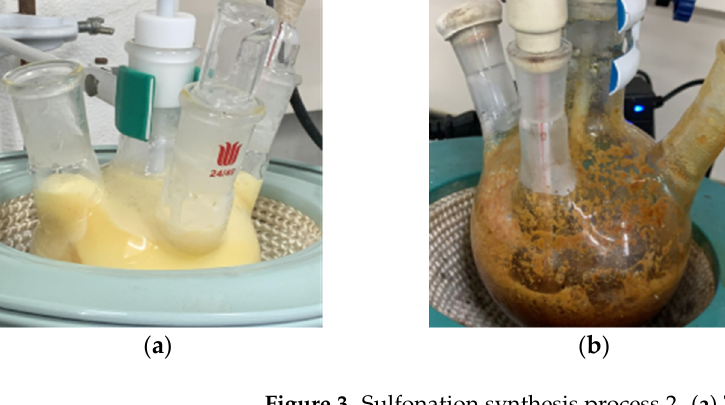
Figure 3. Sulfonation synthesis process 2. ( a ) Temperature rise to 110 °C for reaction; ( b ) after the reaction; ( c ) washed and filtered finished products.